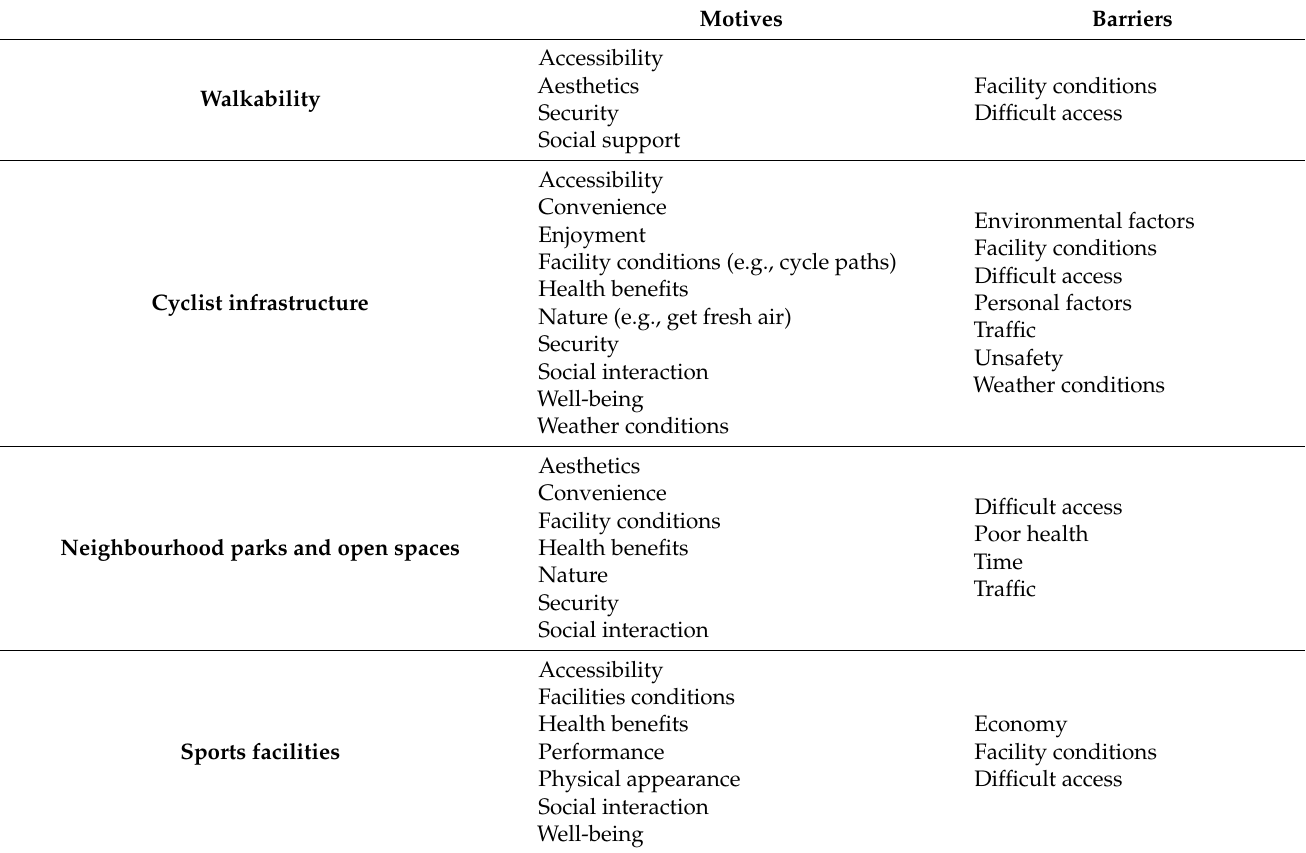
Table 4. Motives and barriers related to physical activity within four different types of built